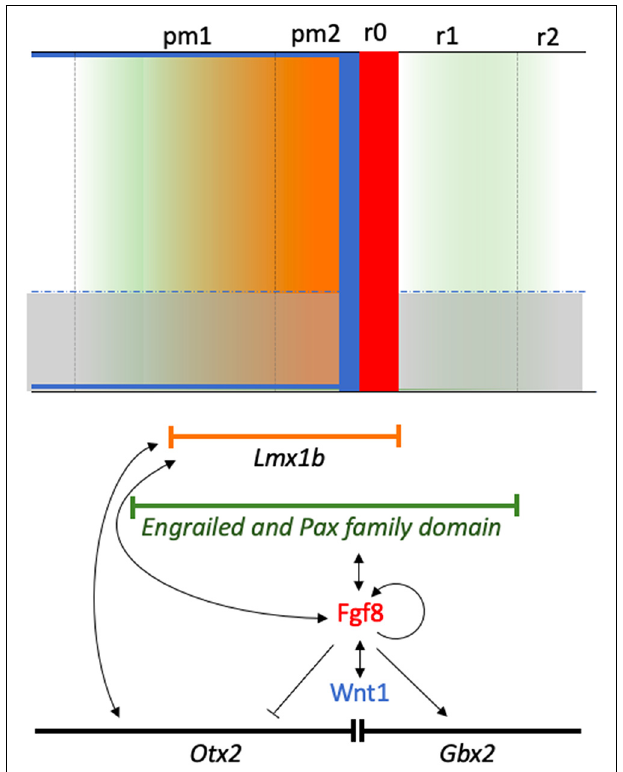
FIGURE 10 | A schematic diagram showing the isthmic neural territory influenced by the morphogenetic activity. The molecular pathways regulating organizer specification are also shown, together with specific local activity associated with the gradient of the signaling molecules (color gradients-color codes). Genetic patterns are represented by their respective symbols inside a lineal sector. Gene interactions are represented by arrows showing the direction of the interaction and inductive effects either positively (arrow) or negatively (no